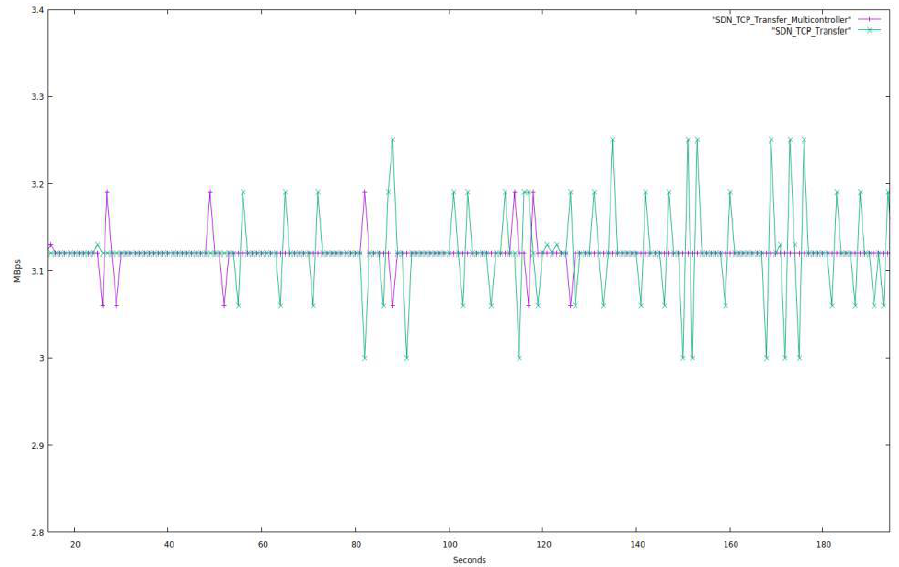
Figure 13. Transfer Rate/Throughput of TCP single-controller SDN vs. TCP Multi-controller SDN.